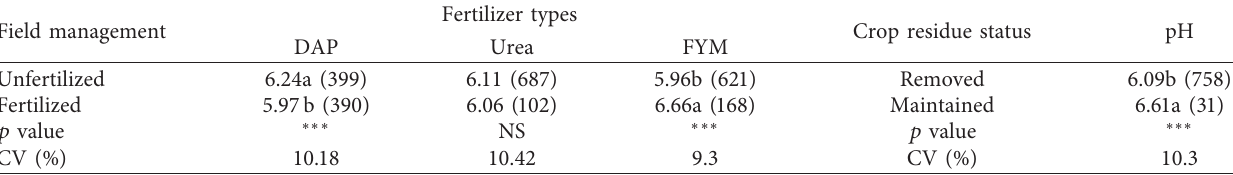
Table 4: Effects of fertilizer types and crop residue management on soil pH.